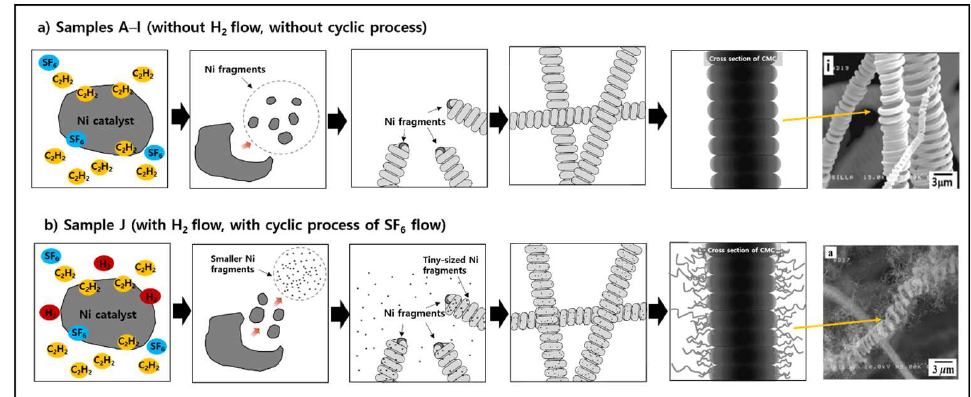
Figure 3. Systematic diagrams indicating ( a ) the formation of controllable CMCs in the C 2 H 2 + SF 6 gas flow system and ( b ) the formation of numerous small-sized CNFs on the surfaces of CMCs caused by H 2 flow injection and the abundant C 2 H 2 flow during SF 6 flow off period in the cyclic process.